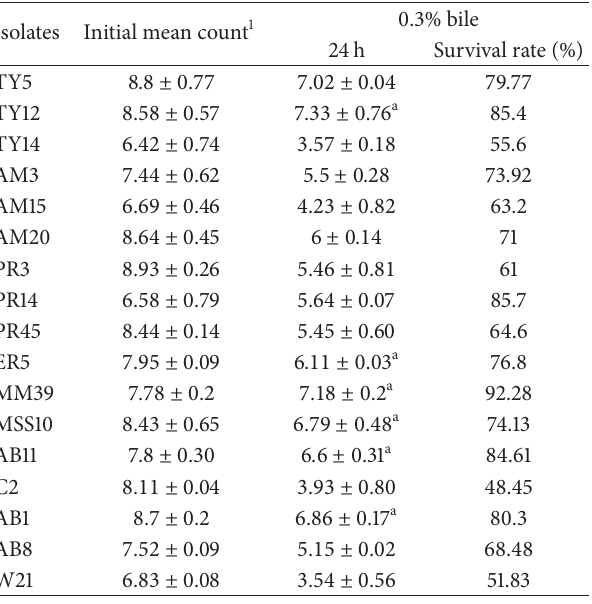
Table 3: Survivability of LAB isolates at 0.3% bile. Isolates Initial mean count